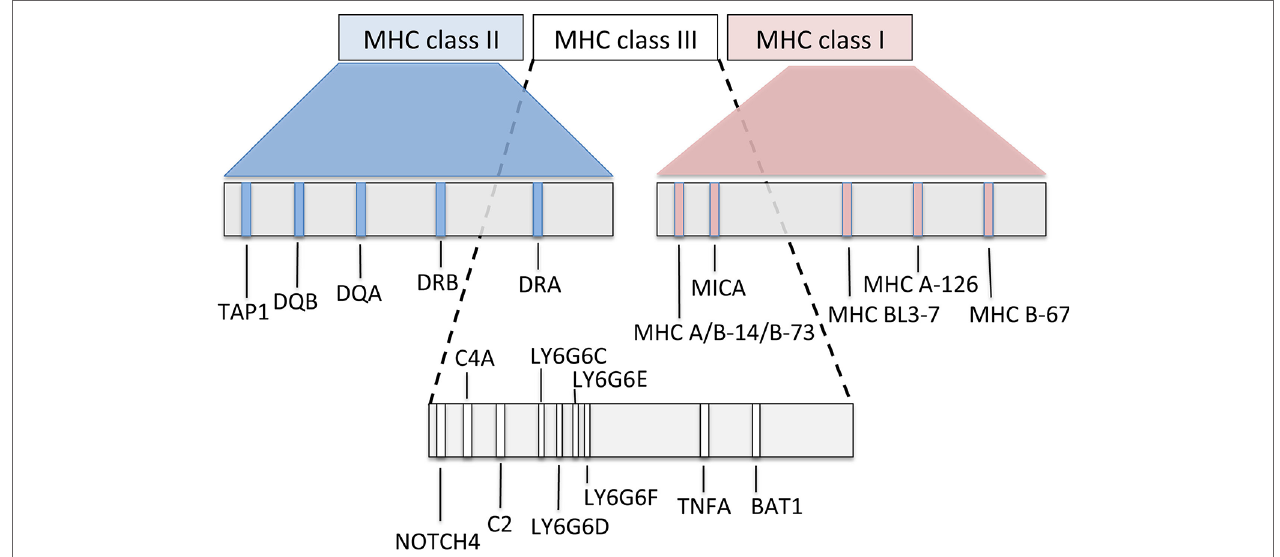
FIGURE 5 | Schematic map of the overall organization of the major histocompatibility complex in Old World camelids, modified from Plasil et al. (2016, 2019).